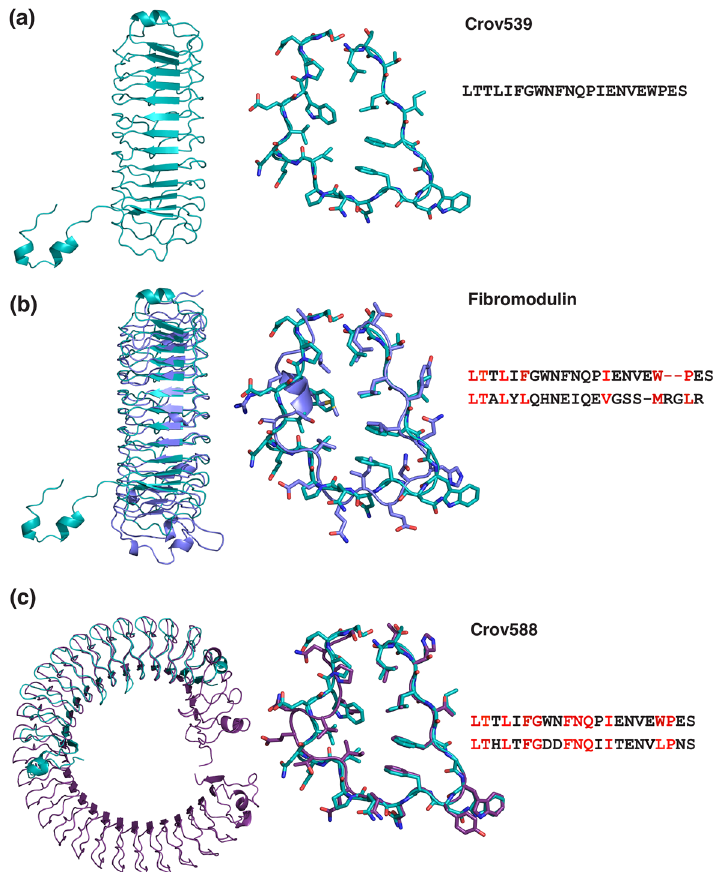
Figure 5. Overlay of structures and aligned LRR motifs for ( a ) Crov539, ( b ) Fibromodulin (5MX0) and ( c ) Crov588